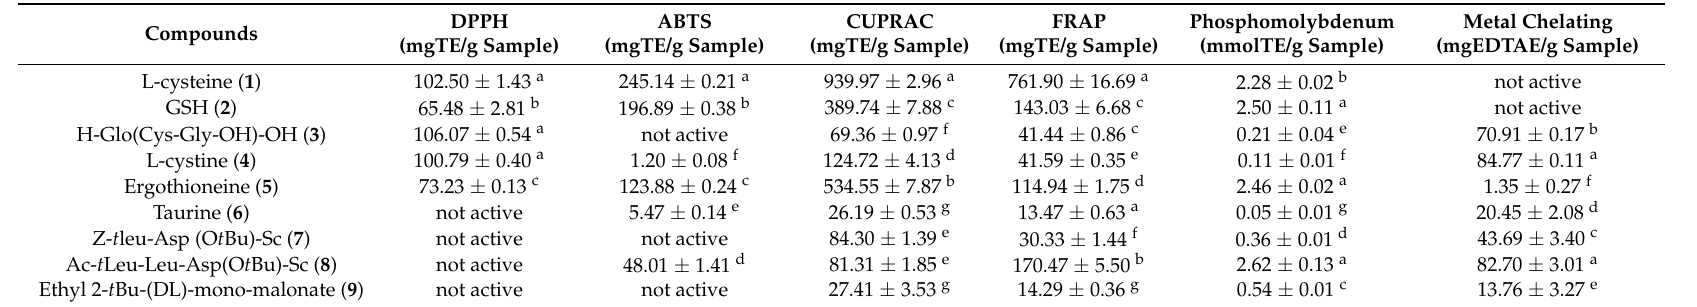
Table 2. Antioxidant capacity evaluation for compounds 1 – 9 .